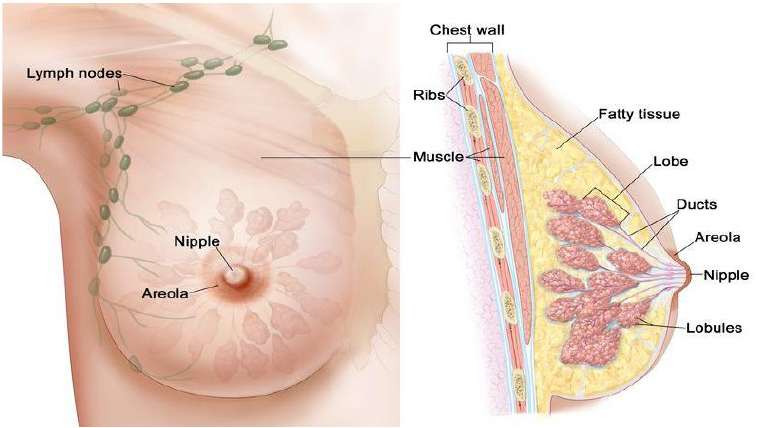
Figure 2. Common cancer incidence locations in female breast [19].